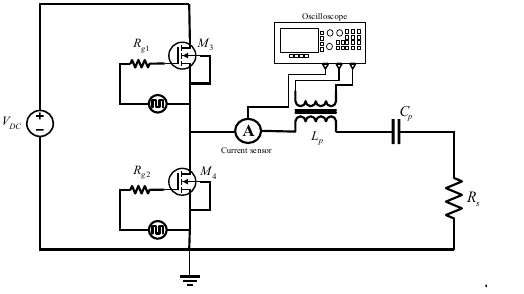
where ω o represents the angular frequency.